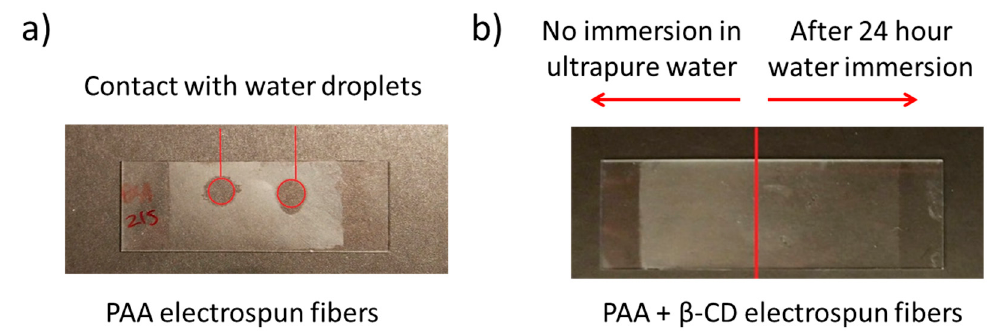
Figure 7. ( a ) Aspect of the poly(acrylic acid) (PAA) electrospun fibres onto glass slides, showing a total remove of the coating after contact with water droplets; ( b ) aspect of the PAA + β -cyclodextrin ( β -CD) electrospun fibres where the coating remains totally unaltered after 24 h immersion in water. Reprinted with permission of [53].